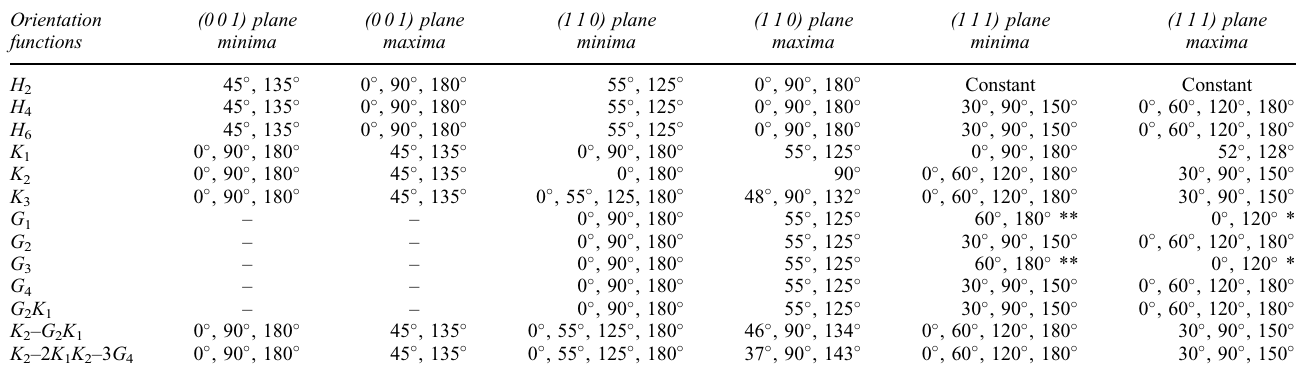
TABLE II Values of Alignment Angle c for which the Polar Plots of Orientation Functions Pass Through Minima and Maxima. Orientation